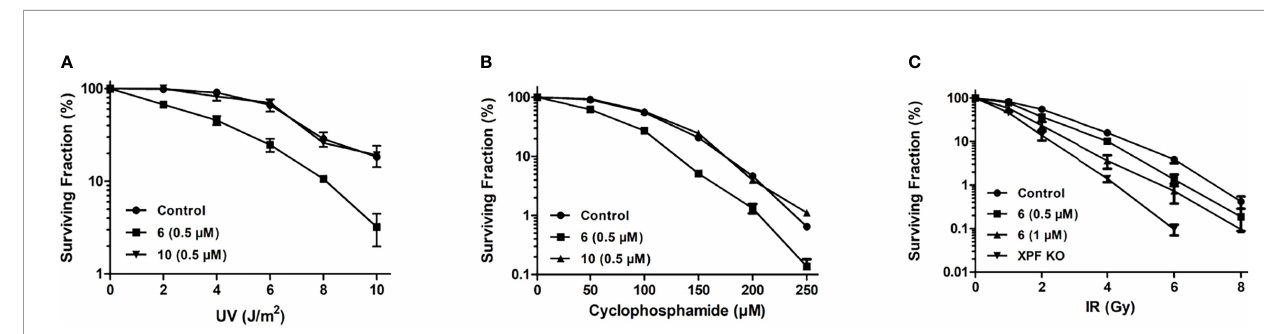
FIGURE 6 | Sensitization of HCT-116 cells to DNA damaging agents as determined by clonogenic survival assay. (A) Survival of HCT-116 cells exposed to increasing doses of 254 nm UV radiation and treated with 0.5 m M compound 6 or 10 (B) Survival of HCT-116 cells exposed to increasing doses of cyclophosphamide and treated with 0.5 m M compound 6 or 10. (C) Survival of HCT-116 cells exposed to increasing doses of ionizing radiation and treated with 0.5 and 1 m M compound 6. The radiosensitivity of HCT-116 XPF knockout cells (70) is provided for